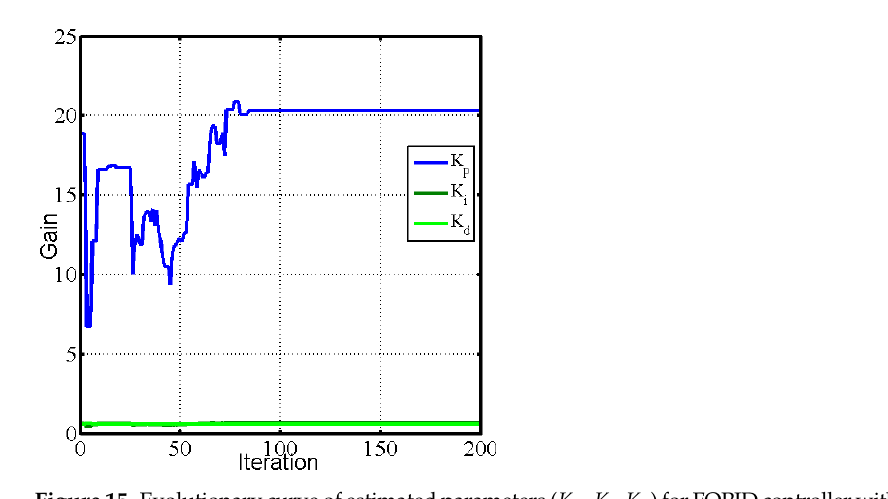
Figure 15. Evolutionary curve of estimated parameters ( K p , K i , K d ) for FOPID controller without